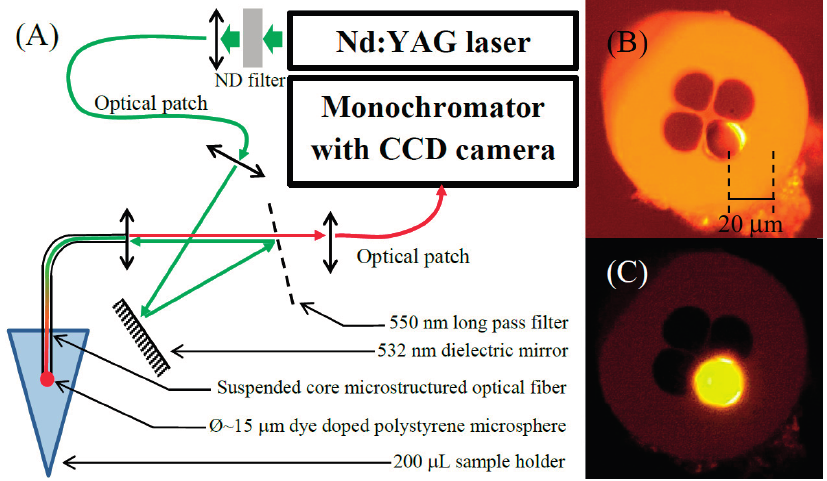
Figure 1. ( A ) schematic of the optical setup; ( B , C ) bright field and fluorescence images of a 20 µm diameter dye doped polystyrene microsphere positioned onto the tip of a suspended core silica fiber respectively (Ø core = 4 µm, Ø hole = 17 µm).